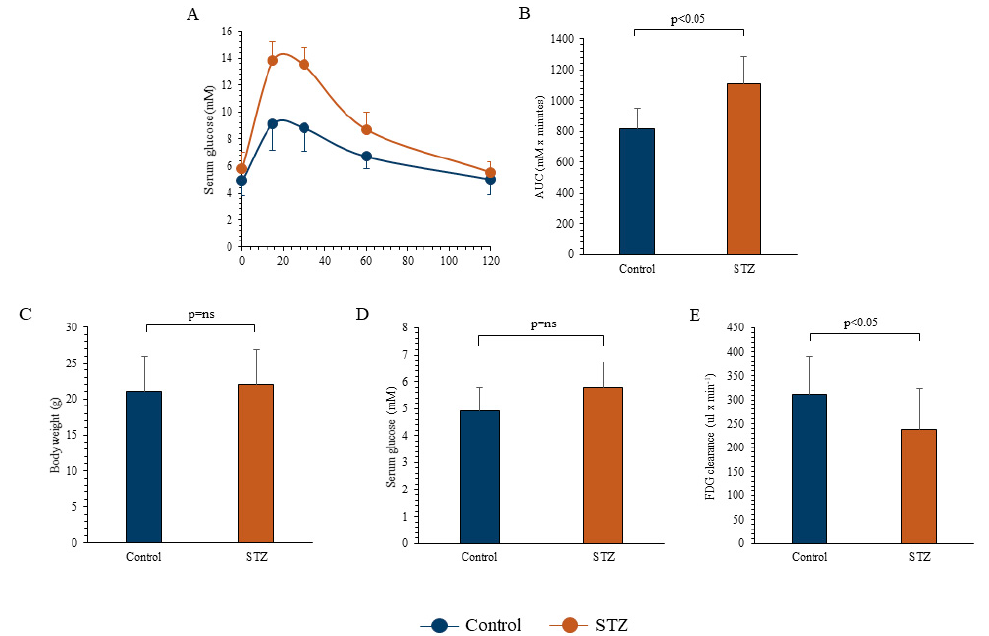
Figure 1. E ff ect of streptozotocin (STZ) on mice serum glucose level, body weight, and clearance. Serum glucose levels at oral glucose tolerance test (OGTT) (Panel A ) and area under the curve (Panel B ) in the 17 control (blue) and in the 23 STZ-treated mice (brown). Body weight (Panel C ) and average fasting glycemia (Panel D ) were measured two weeks after OGTT, soon before PET imaging, in control ( n = 17, blue column) and STZ groups ( n = 23, brown column). Blood 18F-Fluorodeoxyglucose (FDG) clearance was significantly decreased in STZ mice (Panel E ). Data are expressed as mean ±